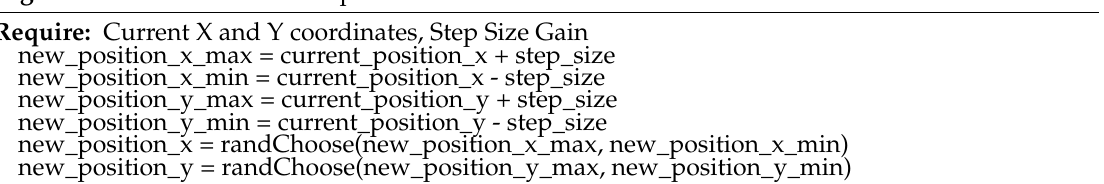
Algorithm 2 Calculate the new position of a node in the full mesh